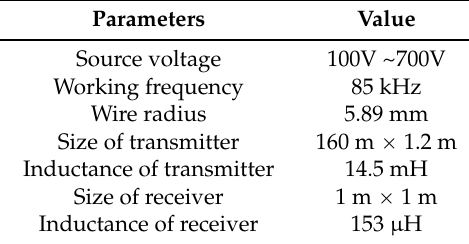
Table 1. Specific parameters of the designed on-road charging system.